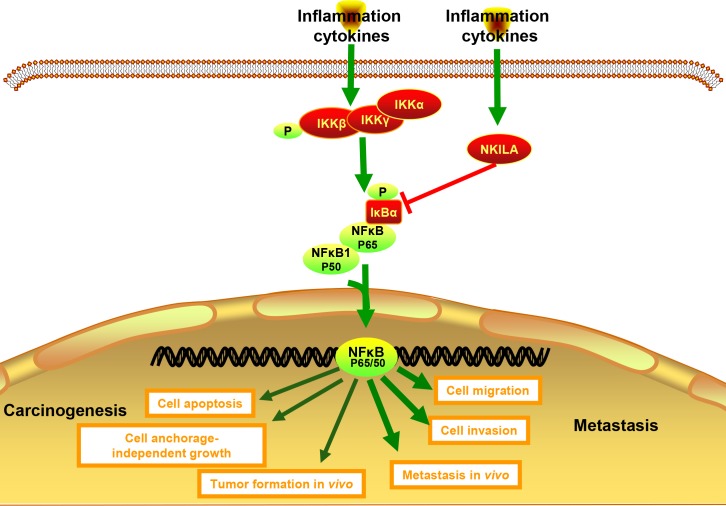
NKILA inhibits the NPC carcinogenesis and metastasis by NF-κB pathway inhibition.Schematic figure depicting the role and mechanism of NKILA in NPC carcinogenesis and metastasis.